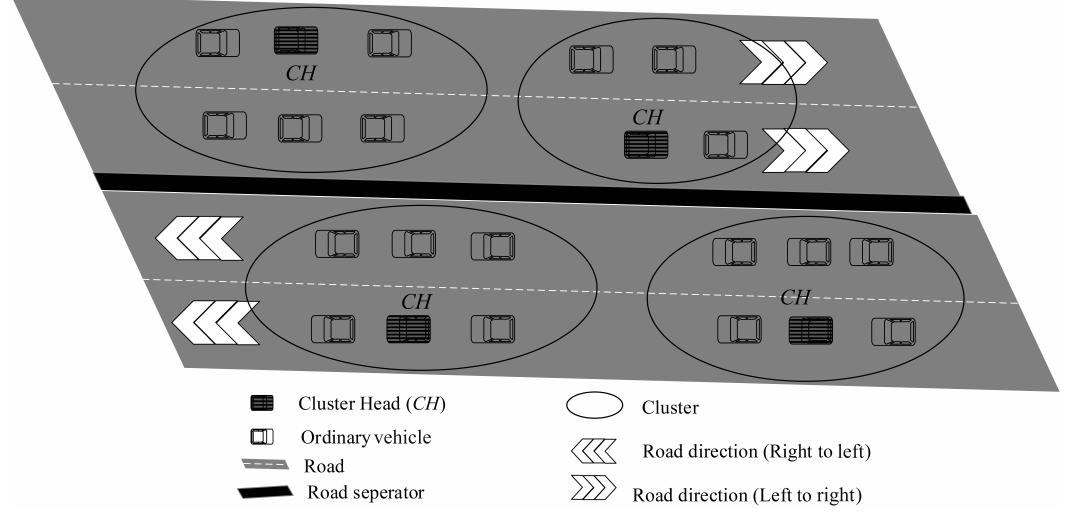
Figure 2. A bi-directional highway scenario.